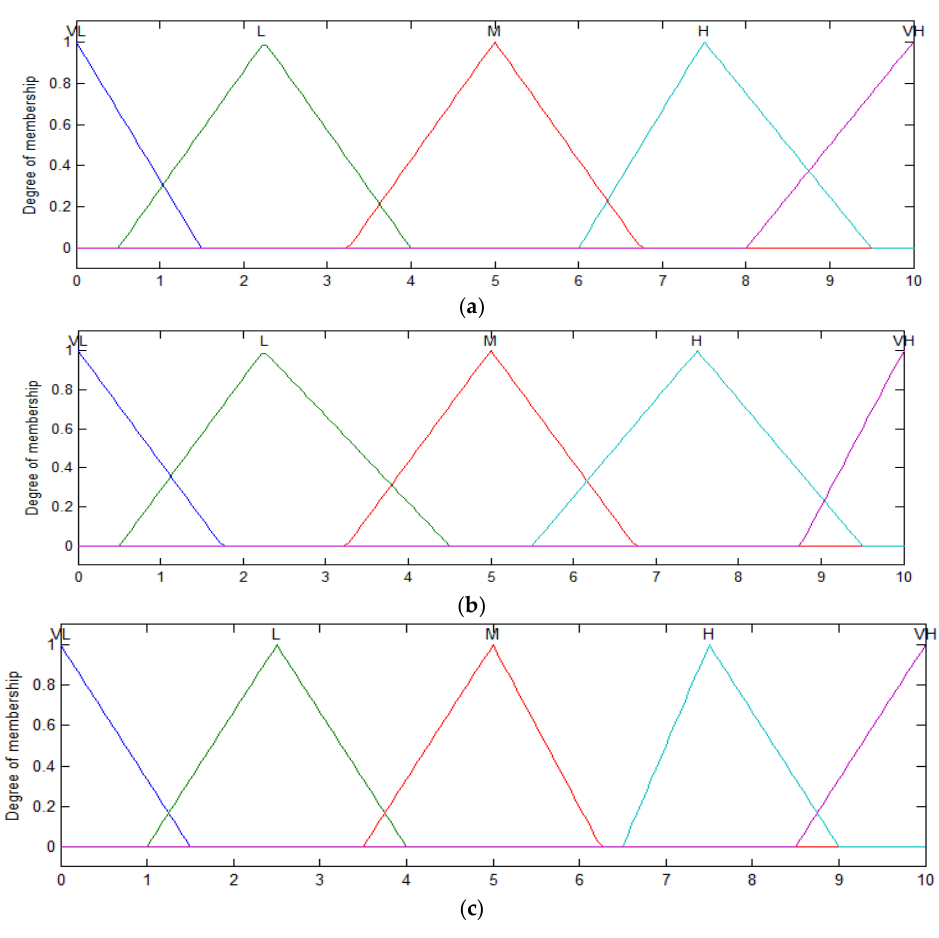
Figure 8. Input/output MFs: ( a ) P 1 ; ( b ) P 2 ; and ( c ) M 1.